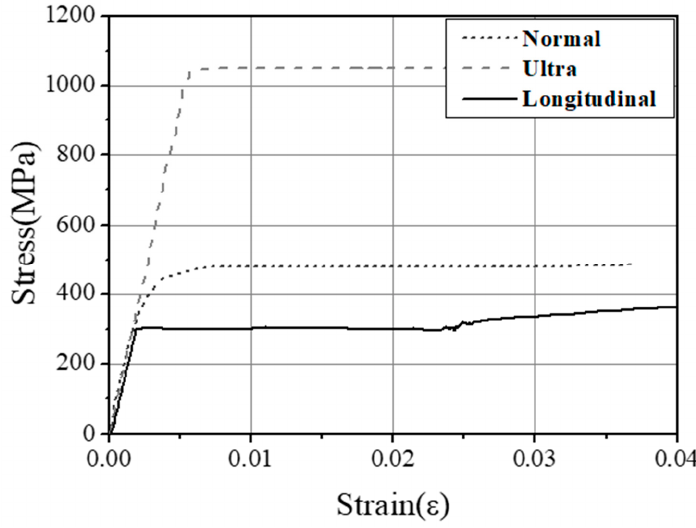
Figure 3. Stress–strain relationship of reinforcement.